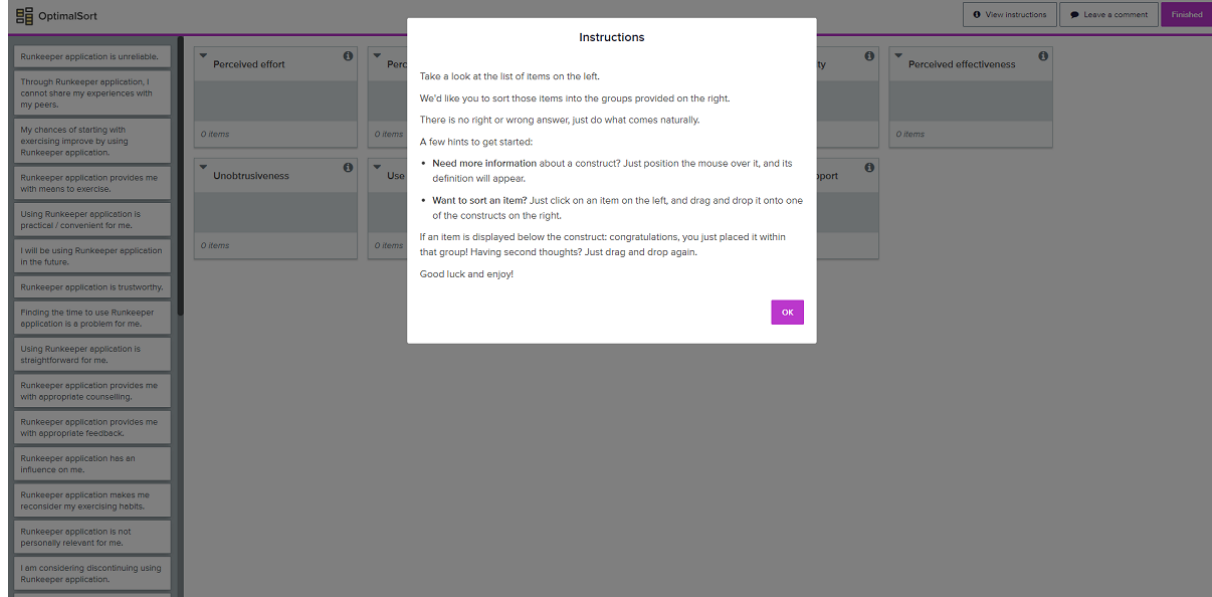
Figure 1. Screenshot of card sort software during